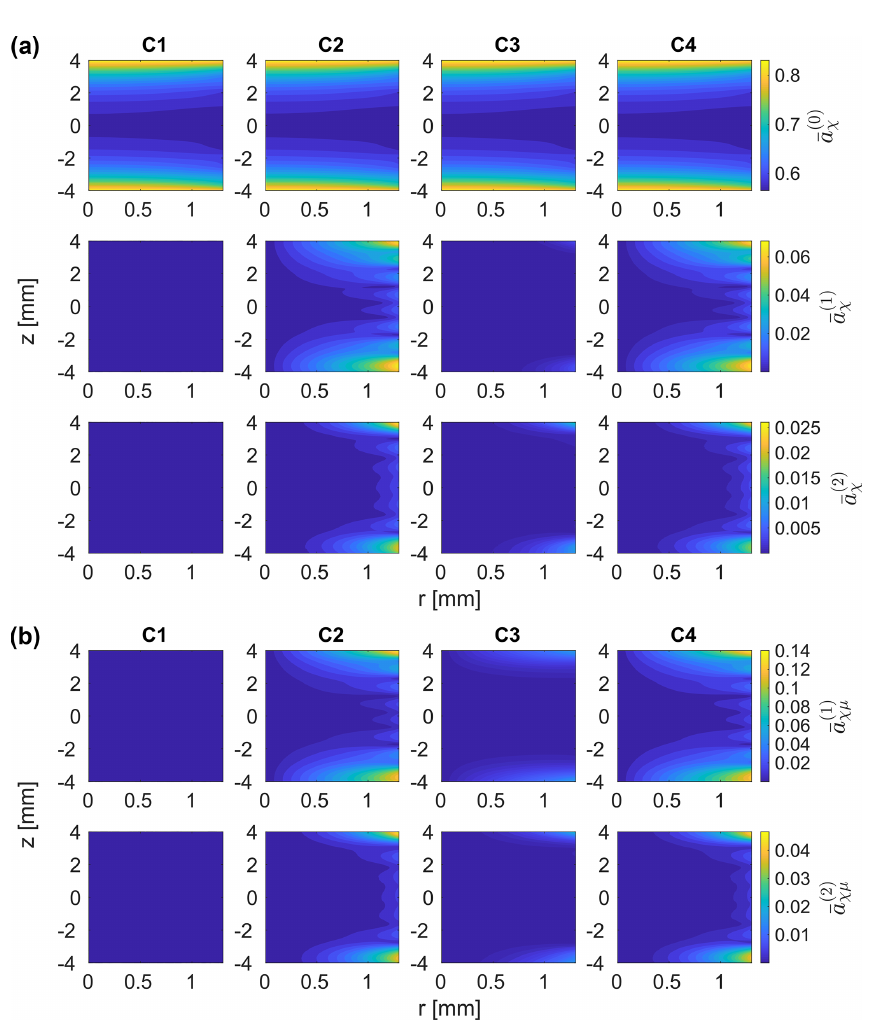
k ) ( k ) Figure 13. Norm of the scaling factors of the chemical shift terms a ( χ (for k = 0 , 1 , 2, a ) and the homonuclear dipolar coupling terms a χµ (for k = 1 , 2, b ) in the first-order effective Hamiltonian for FSLG decoupling for C1–C4. Coefficients were extracted from interaction frame trajectories of single-spin operators for a nominal rf field strength of 125kHz along the magic angle and a MAS frequency of 12.5kHz in a 3.2mm MAS probe. (a) The scaling of the isotropic chemical shift ( k = 0) is unaffected by the time-dependent rf field modulations (no difference between C1–C4) and is close to the ideal value of cos θ m ≈ 0 . 577 in the centre of the rotor, where the rf field amplitude corresponds to the nominal rf field strength. Scaling factors increase towards the rotor edges where the rf field amplitude is significantly lower, leading to a smaller tilt angle. Additional non-zero coefficients for k = 1 and 2 terms are obtained when amplitude modulations are taken into account (C2 and C4). (b) Amplitude modulations (C2 and C4) lead to non-zero scaling factors and, thus, to the reintroduction of dipolar couplings in areas where strong modulations occur. No significant effects are observed for the two remaining